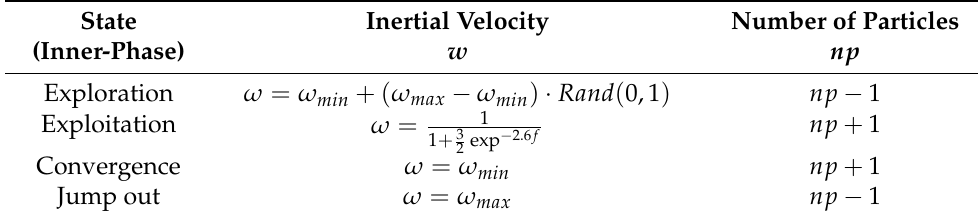
Table 1. Parameters update by identified state.